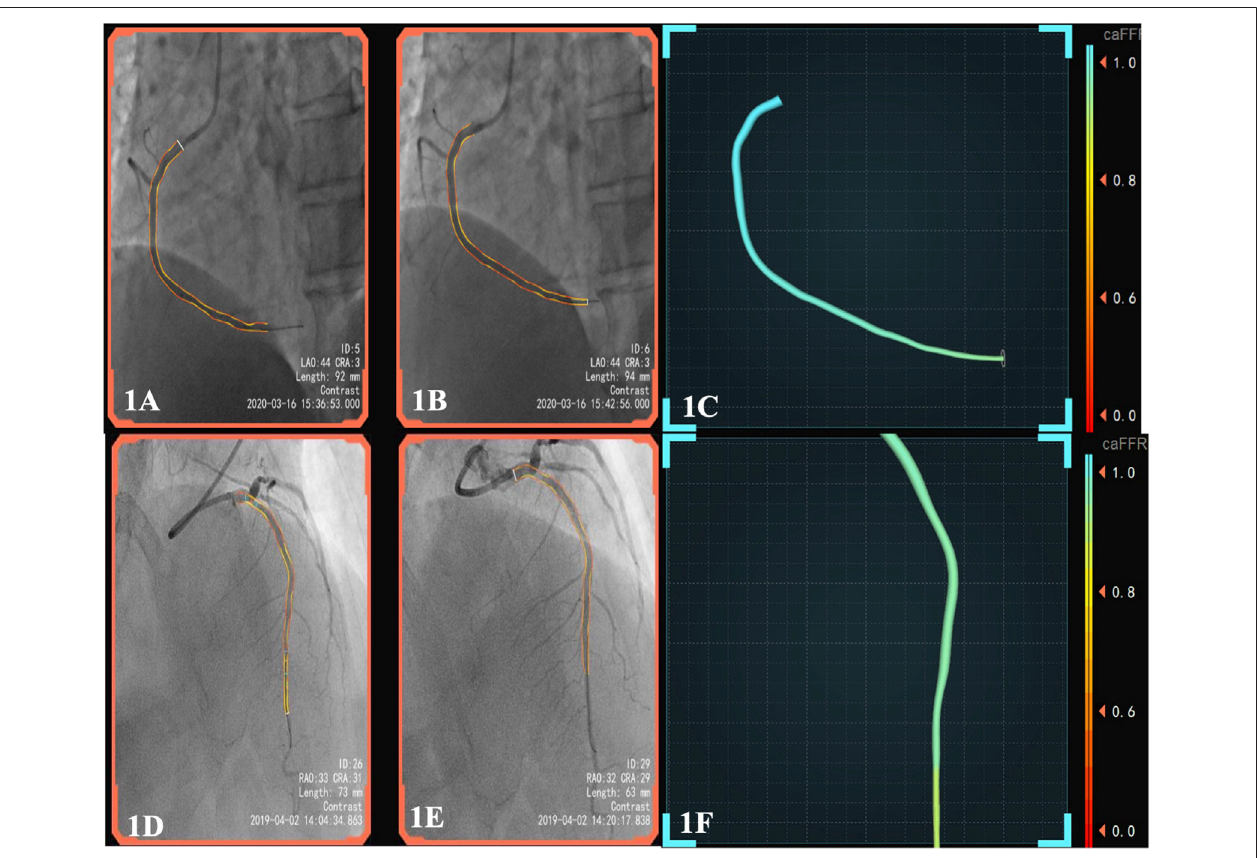
FIGURE 1 | (A) , pre-surgery angiography; (B) , post-surgery of DCB; (C) , the patient ’ s post-operative caFFR was normal and caIMR was high (caFFR = 0.92, caIMR = 42.1). After 6 months of follow-up, the patient had myocardial infarction again.; (D) , pre-surgery angiography; (E) , post-surgery of DES; (F) , the patient ’ s postoperative caFFR and caIMR (caFFR = 0.91, caIMR = 22.8) were normal and no MACEs events occurred in 1.5 years of follow-up. Abbreviations: caFFR, coronary angiography-derived fractional fl ow reserve; caIMR, coronary-angiography-derived index of microcirculatory resistance; DES, drug-eluting stents; DCB, drug- coated balloons; MACE, major adverse cardiovascular